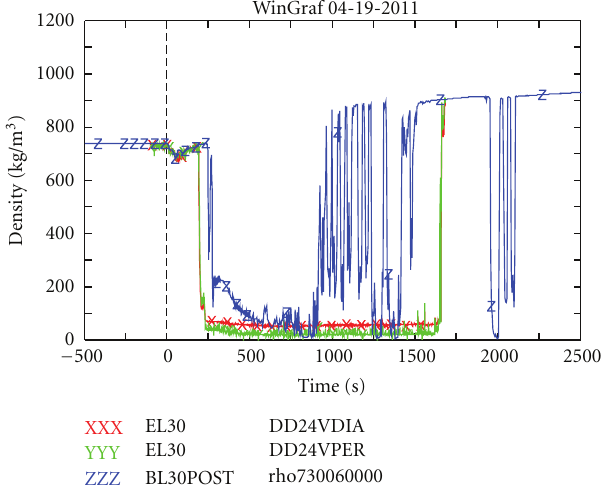
Figure 10: Broken loop seal (pump inlet) density.